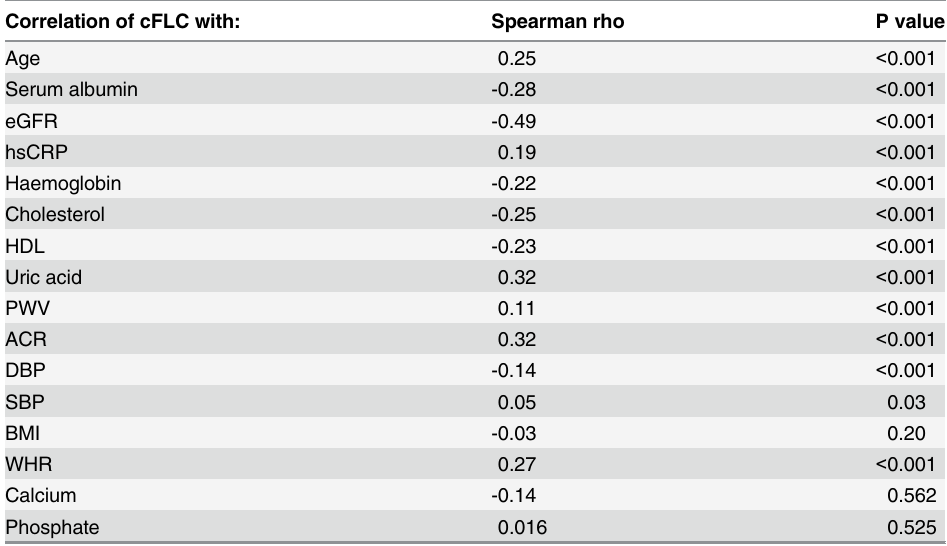
Table 3. Correlation of cFLC with other clinical